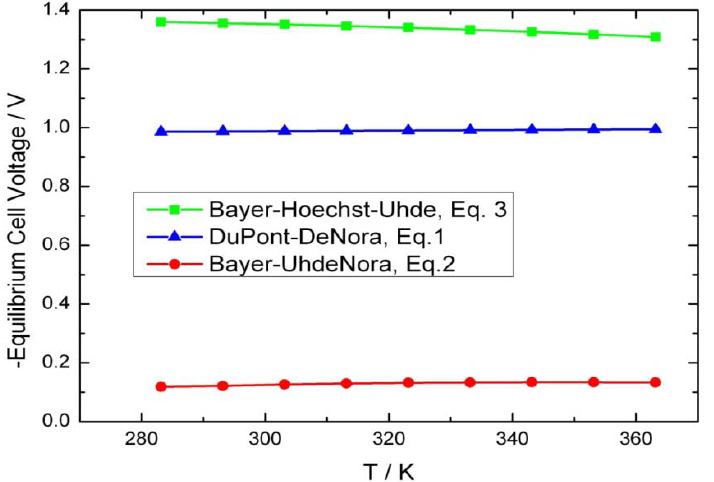
Figure 2. Influence of temperature on equilibrium cell voltage for different HCl electrolysis